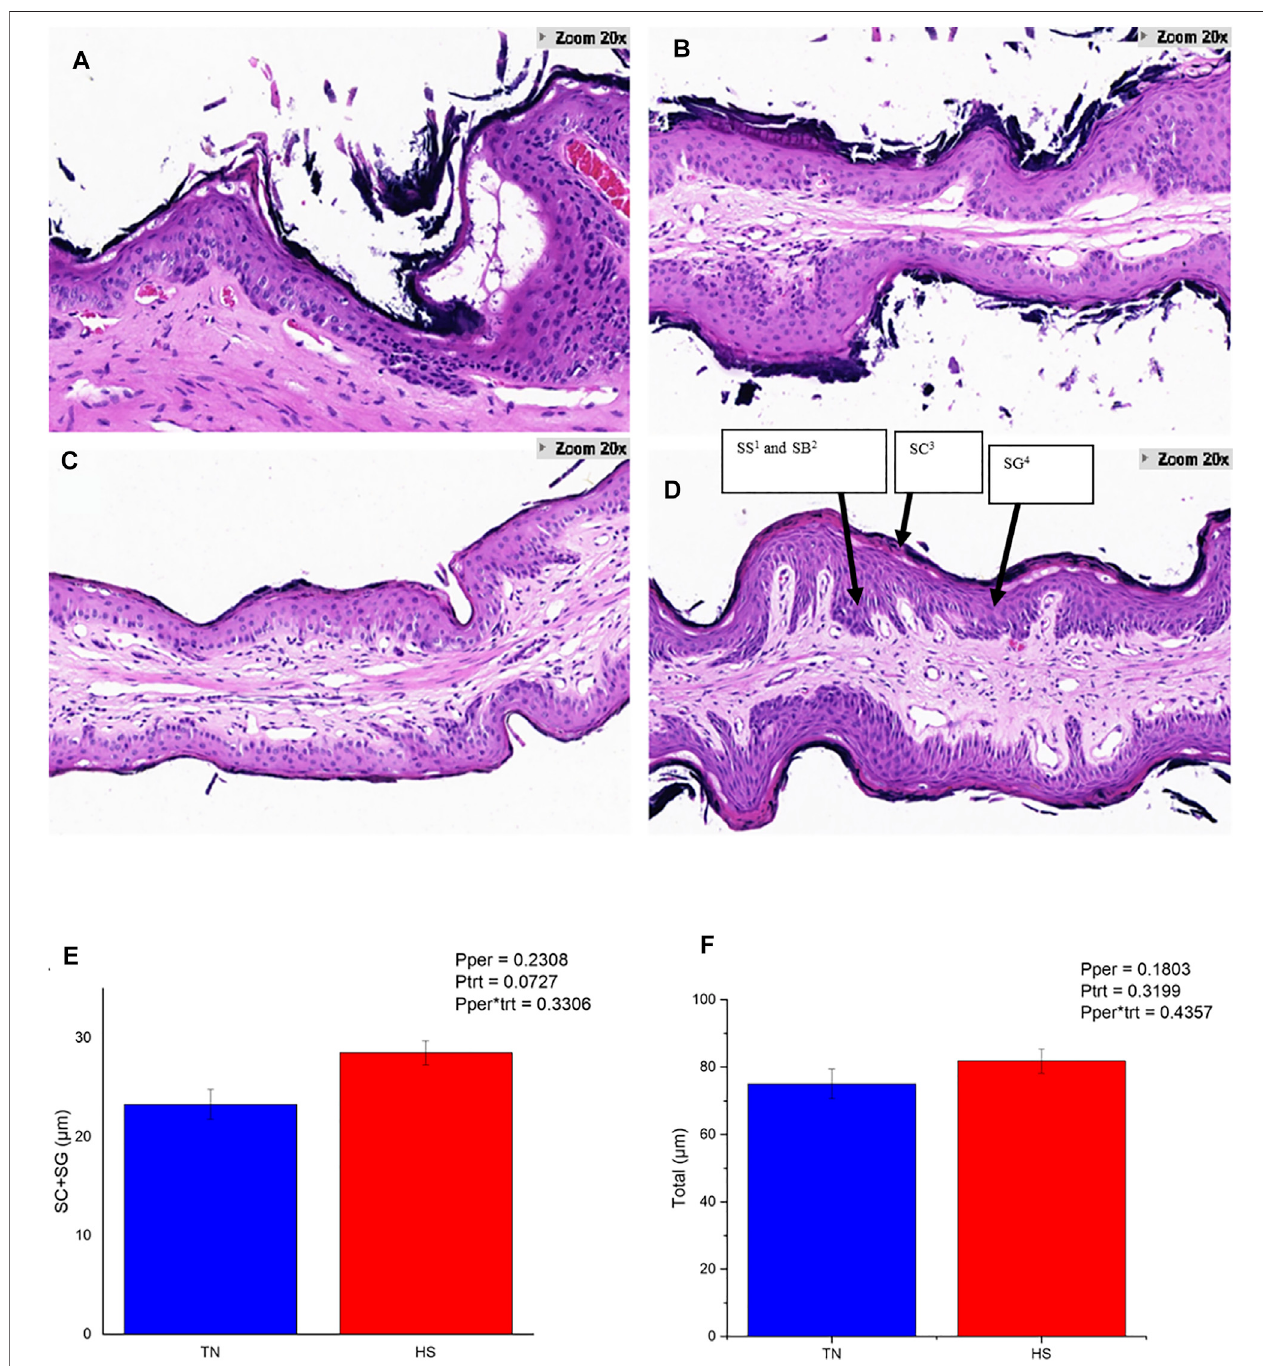
FIGURE 1 | The rumen papillae structure of HS cows (A,B) and PFTN cows (C,D) , and their thickness of the stratum corneum (SC) plus stratum granulosum (SG) layers of the rumen epithelium (E) as well as total epithelial thickness (F) . 1) Stratum Spinosum.2) Stratum Basale.3) Stratum Corneum.4) Stratum Granulosum.